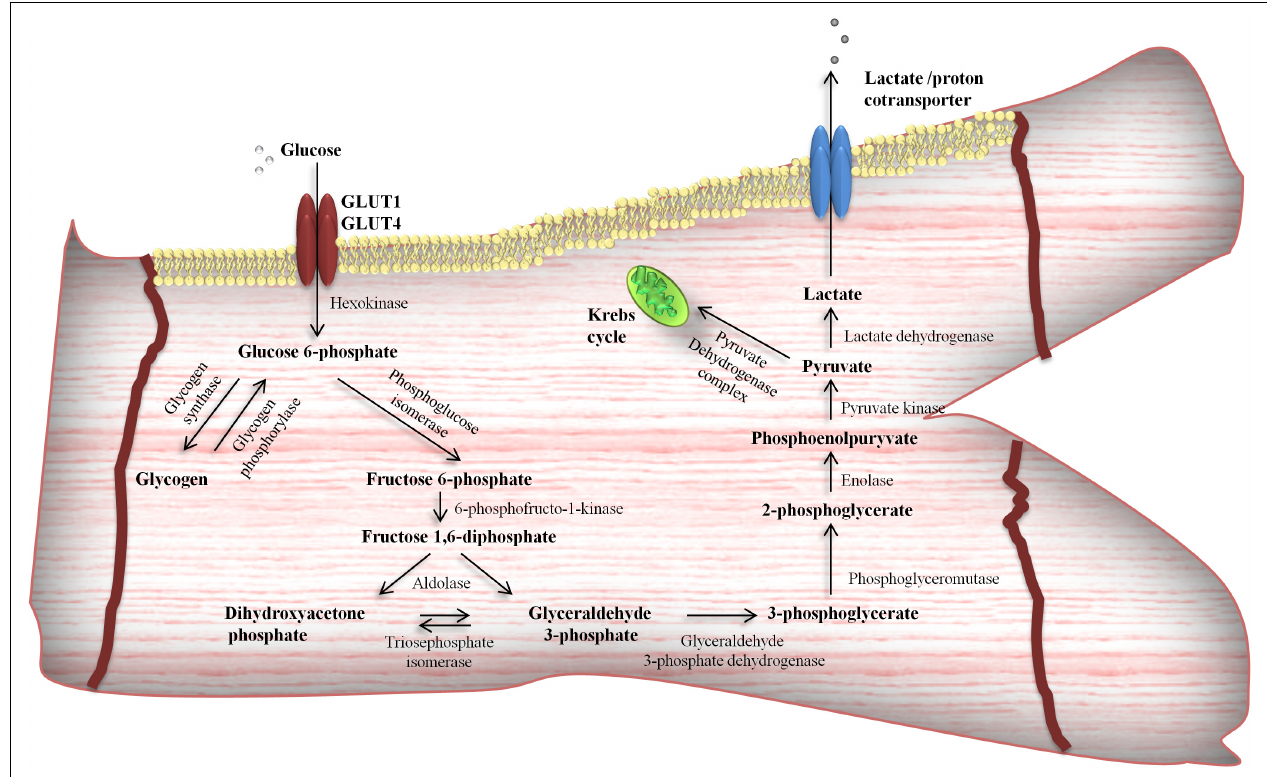
FIGURE 2 | Glycolytic pathway in cardiomyocytes. Glucose after entering the cells via facilitated diffusion [glucose transporter 4 (GLUT4)] can undergo different intramyocardial metabolic pathways and become available for energy production or stored as a